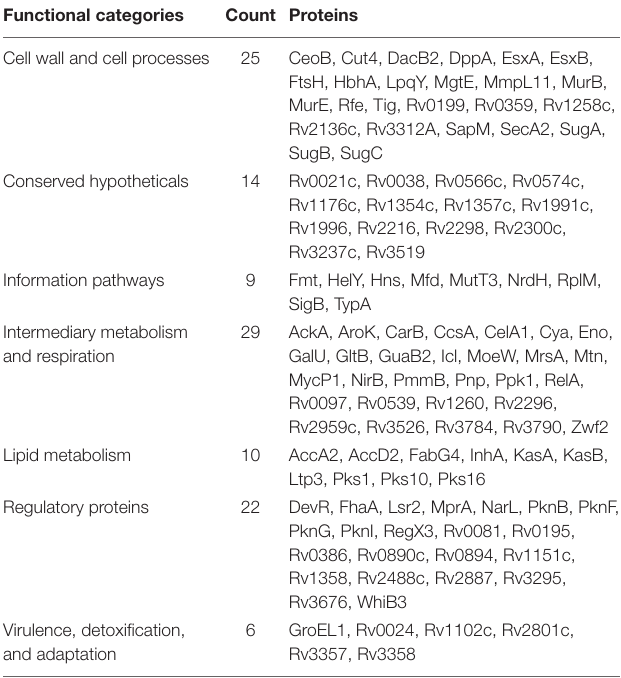
TABLE 1 | Biofilm- and quorum sensing-associated proteins (BQAPs) categorized based on TubercuList functional classes.